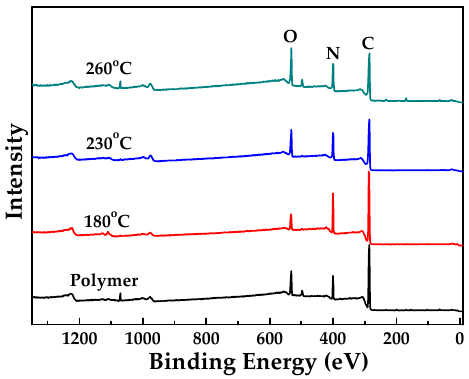
Figure 4. XPS spectra of the PAN and CLA-PAN membranes obtained at different cross-linking temperatures.